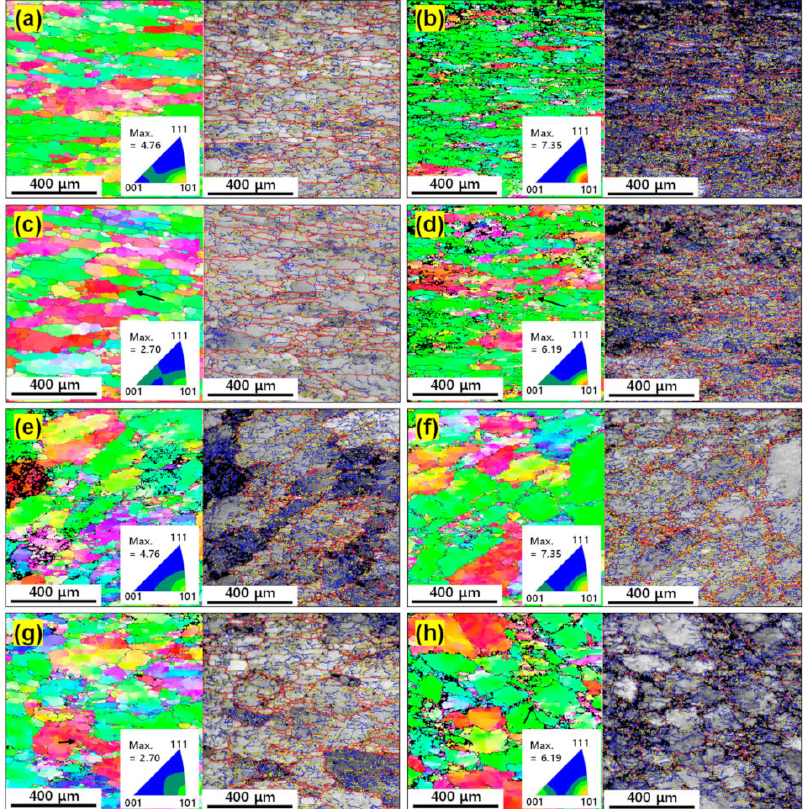
Figure 7. The IPF and grain boundary (GB) maps of the as-cast alloy at ( a ) 673 K–10 − 3 s − 1 , ( b ) 673 K–10 − 1 s − 1 , ( c ) 723 K–10 − 3 s − 1 and ( d ) 723 K–10 − 1 s − 1 . The IPF and GB maps of the extruded alloy at ( e ) 673 K–10 − 3 , ( f ) 673 K–10 − 1 s − 1 , ( g ) 723 K–10 − 3 s − 1 and ( h ) 723 K–10 − 1 s − 1 . Low-angle grain boundaries ◦ ≤ θ < ◦ (2 5 ), intermediate-angle grain boundaries (5 ◦ ≤ θ (15 ) are represented by blue, yellow and red colors, respectively. The insets show the inverse pole figures of the as-cast and extruded